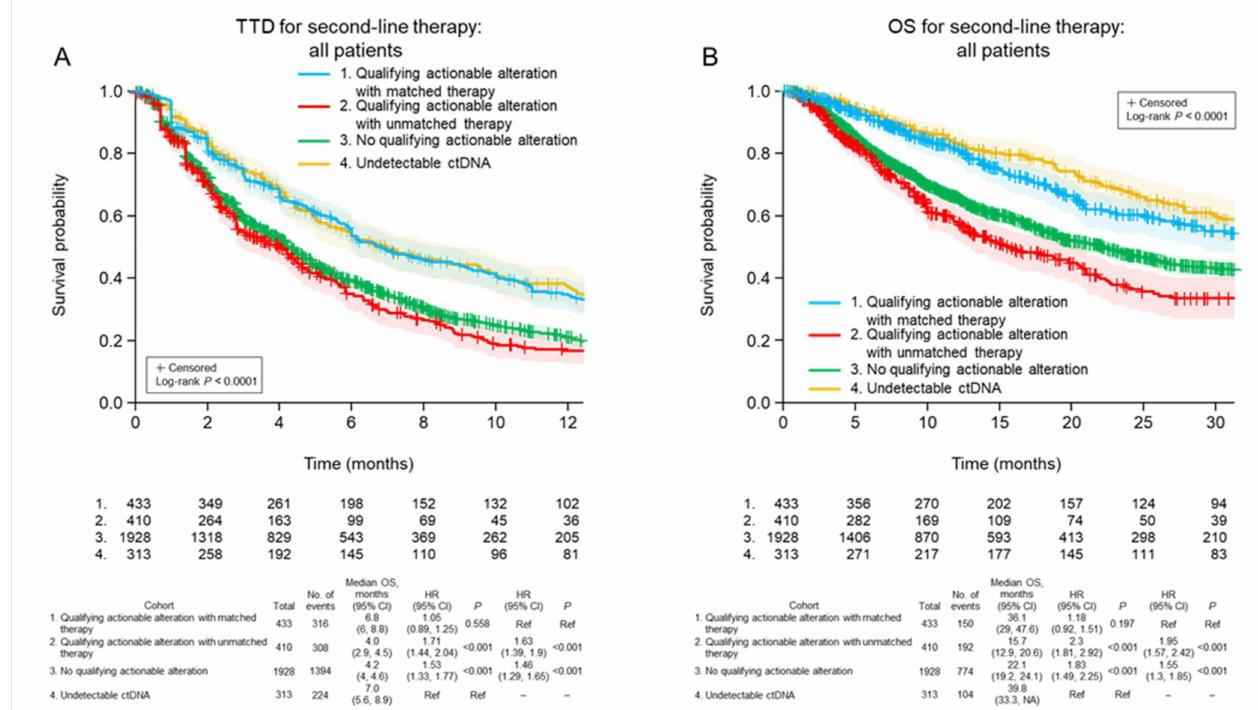
Figure 2. Time to discontinuation of second-line treatment ( A ) and overall survival ( B ) after ctDNA testing in the four patient cohorts, irrespective of the class of first-line treatment received. CI, confidence interval; HR, hazard ratio; TTD, time to treatment discontinuation; OS, overall survival; Ref,